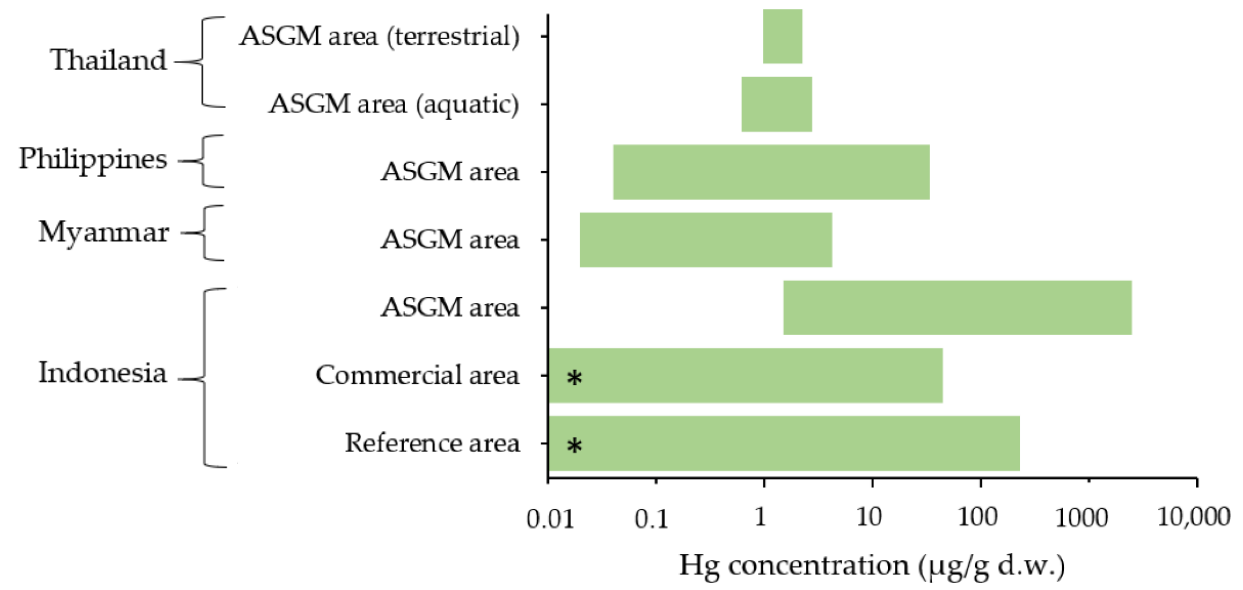
Figure 8. Hg concentrations in plants from Indonesia [51], Myanmar [18], the Philippines [27], and Thailand [31]. Each datum represents Hg concentration of range value, which was from a single study. * . minimum value of “0” .